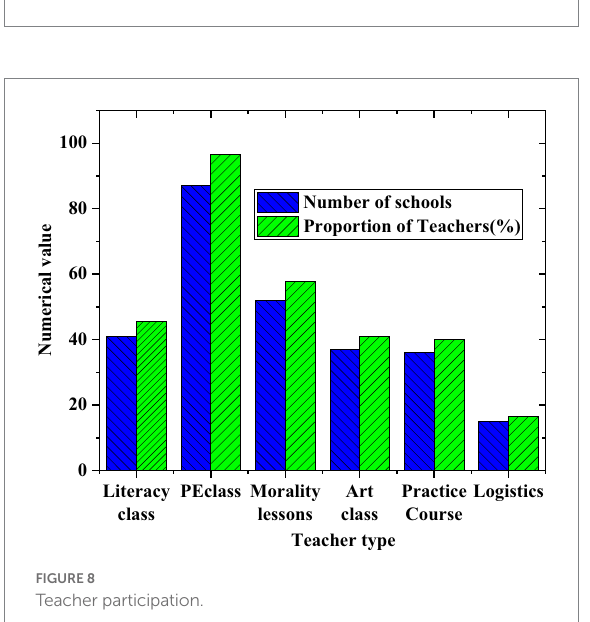
FIGURE 7 Composition of teachers’ academic qualifications.